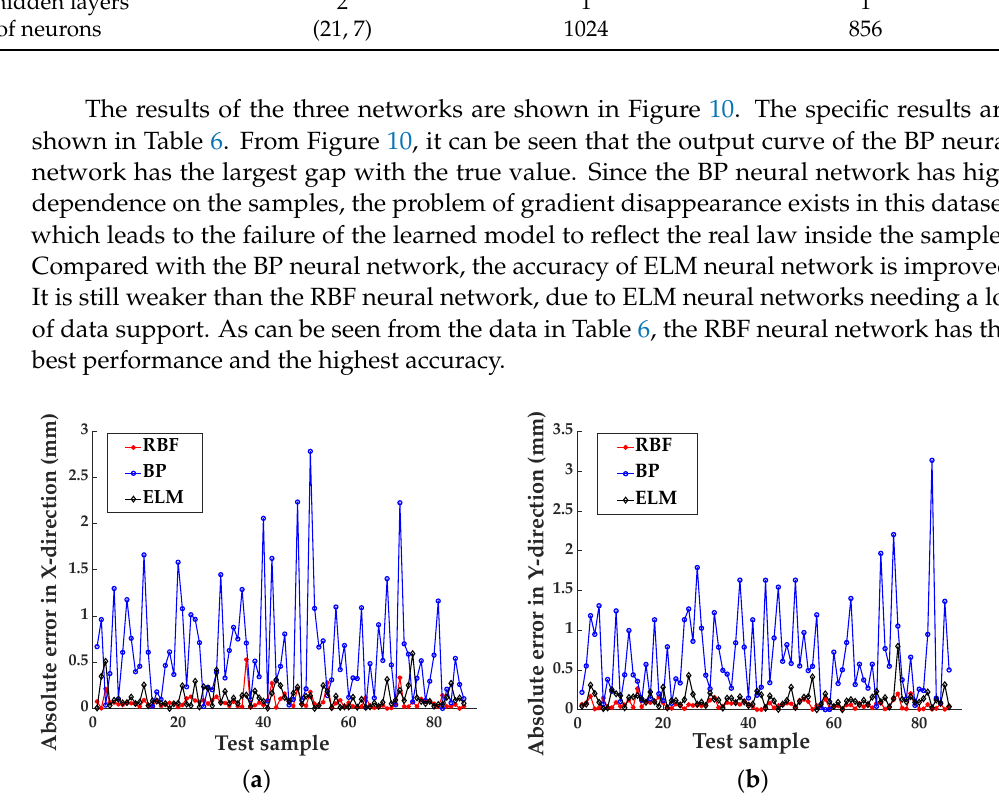
Figure 10. Comparison of three network models, ( a ) absolute error in X -direction, ( b ) absolute error in Y -direction. Table 6. Influence of the number of sensors on accuracy.